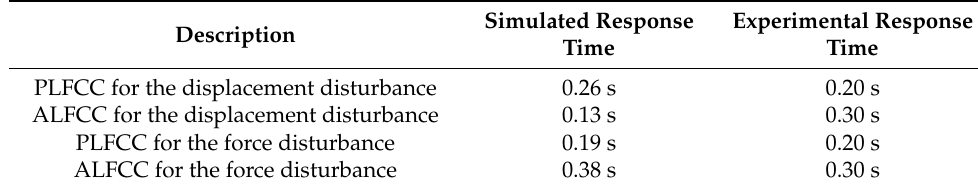
Table 4. Comparison results of the response time.